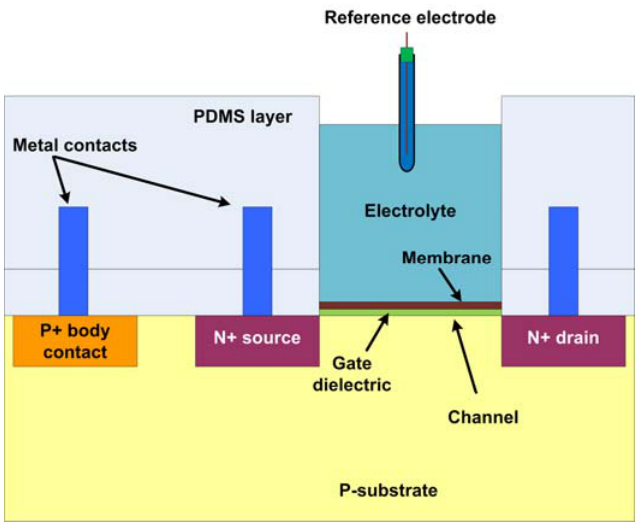
Figure 14. Simplified structure of an ISFET